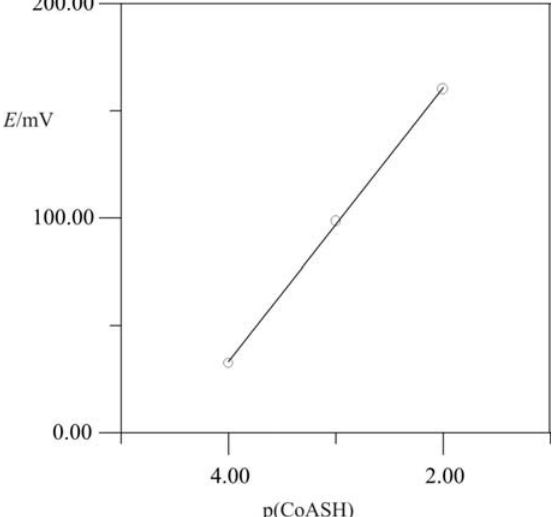
Figure 3. Response of CoASH in flow-injection system with iodide ion-selective electrode (ISE) as detector. Experimental values are represented with dots and calculated ones with a straight